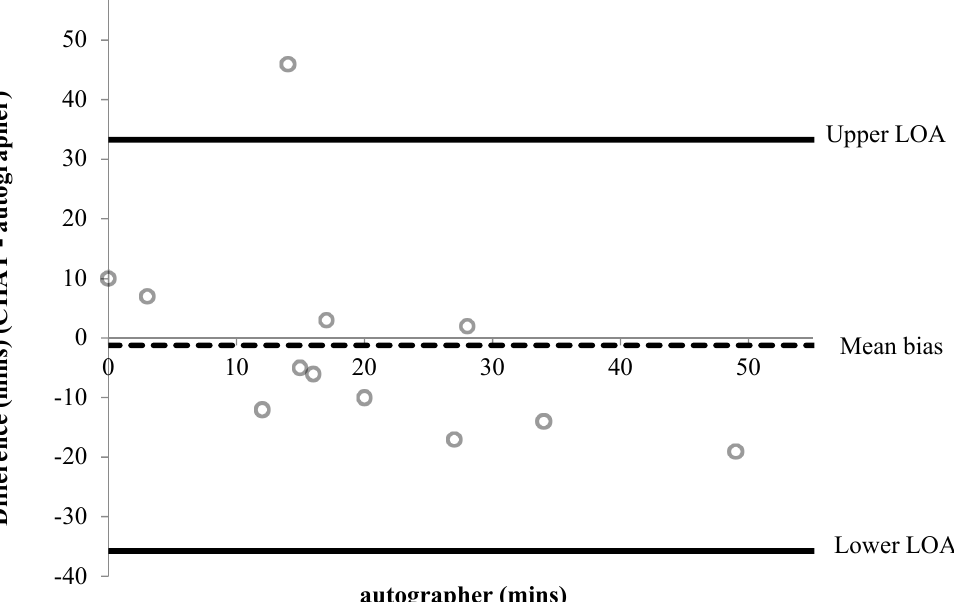
Figure 3. Bland–Altman plot demonstrating the difference between self-reported and autographer- derived before lessons screen time ( n = 12). A mean bias of − 1 min ( ± 18 min) with LOA of + 33 and − 36 min is shown.